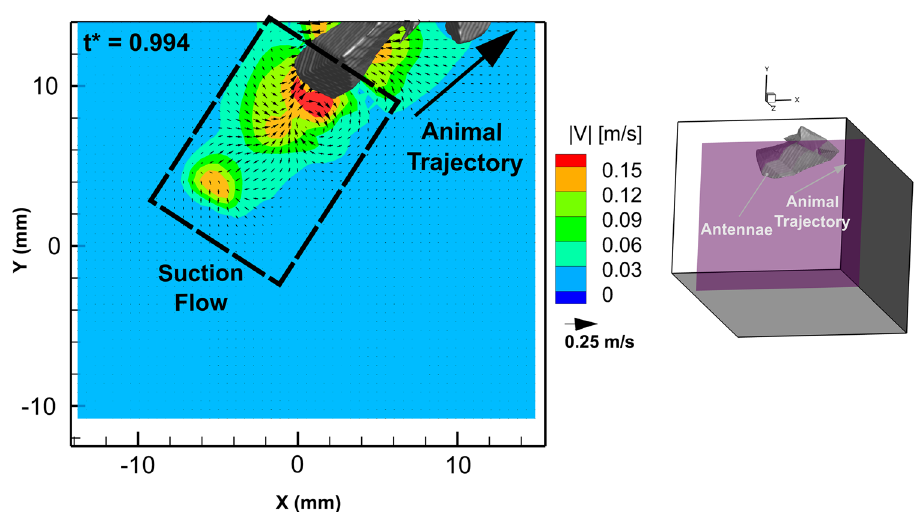
Figure 5. Snapshot at t* = 0.994 of the velocity field in a XY plane (for Z = 4.86 mm) bisecting the dorsal region of the animal while E. superba moves through the plane after the abdominal closure and increase in velocity. The XY plane was extracted from the full 3D vector flow field. The color contours correspond to the fluid velocity magnitude. To help to orient the planar field, a small 3D reconstruction of the slice orientation with respect to the 3D visual hull is shown on the